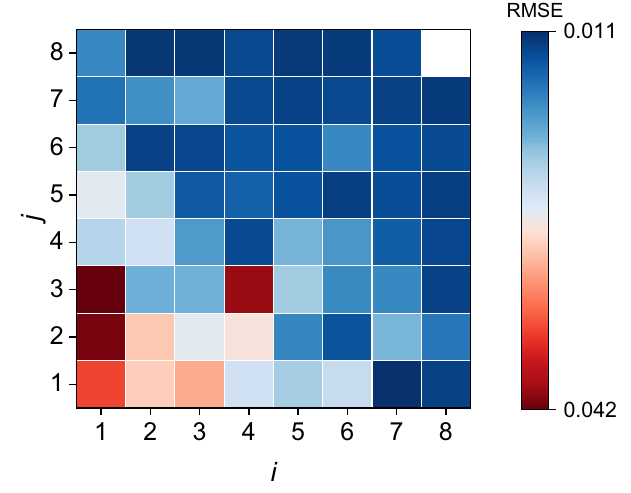
Fig. 3 Cross-validation root-mean-square error (RMSE) of the XGBoost method using different feature combinations. ( i, j ) means different feature combinations referring the Supplementary Table 10. The ( 7, 1 ) = [Var, Ske, Max] obtains the best cross-validation RMSE = 1.0% within a three feature